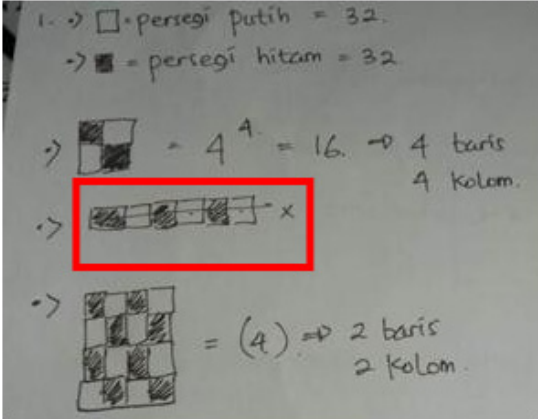
Figure 5. The Mathematics Anxiety